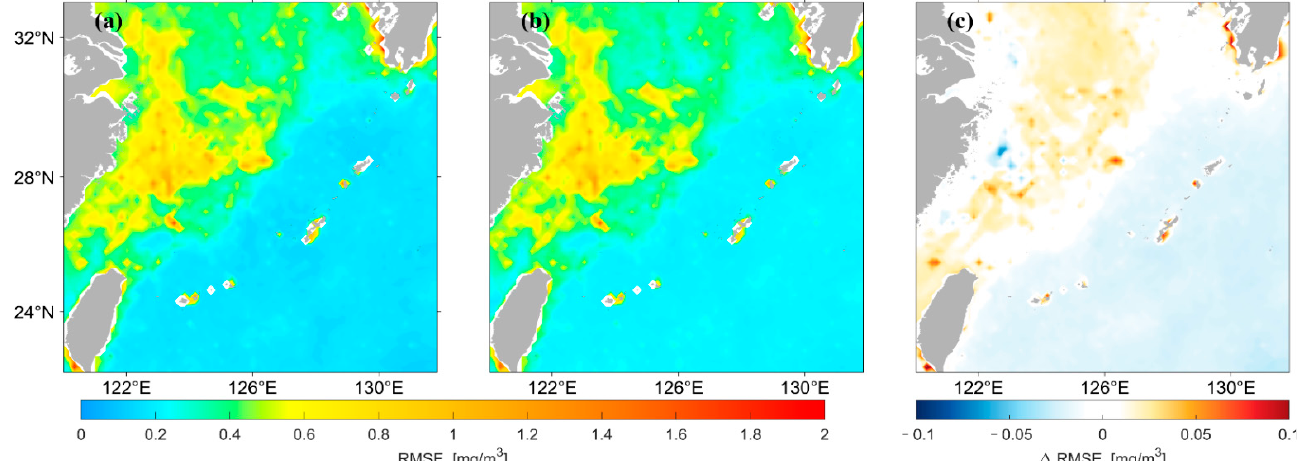
Figure 9. Spatial distribution of RMSE divided by the average of Chl-a predicted by the two LSTM models. ( a ) is the result predicted using the original data as input, ( b ) is the result predicted using the logarithmic data as input, ( c ) represents ( a , b ).